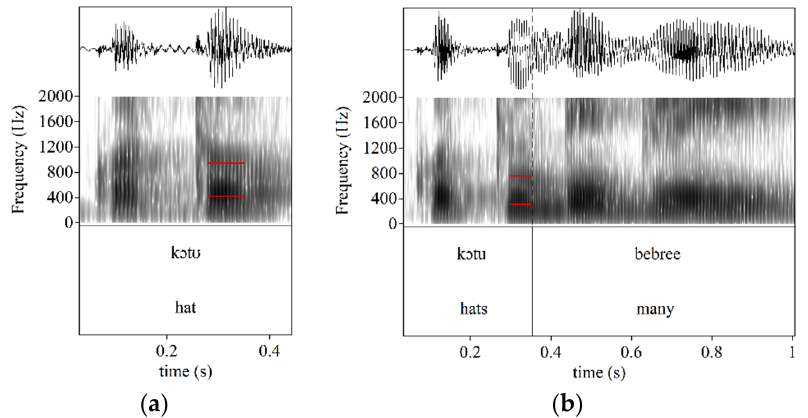
Figure 1. ( a ) Waveform, spectrogram of the noun k ɔ t ʊ ‘hat’; ( b ) Waveform, spectrogram of the NP k ɔ t ʊ bebree ‘many hats’. In complex NPs containing two modifiers, RVH also occurs between modifiers (8d-